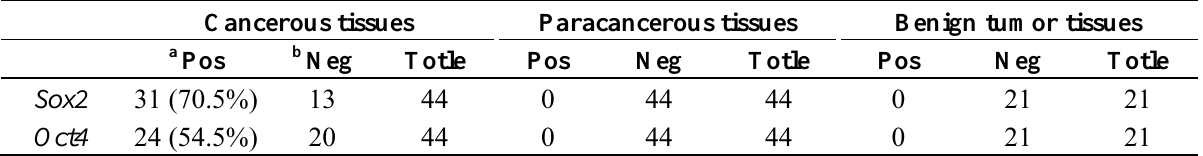
Table 1. Sox2 and Oct4 expressions in cancerous tissues, precancerous tissues and benign lung tumor